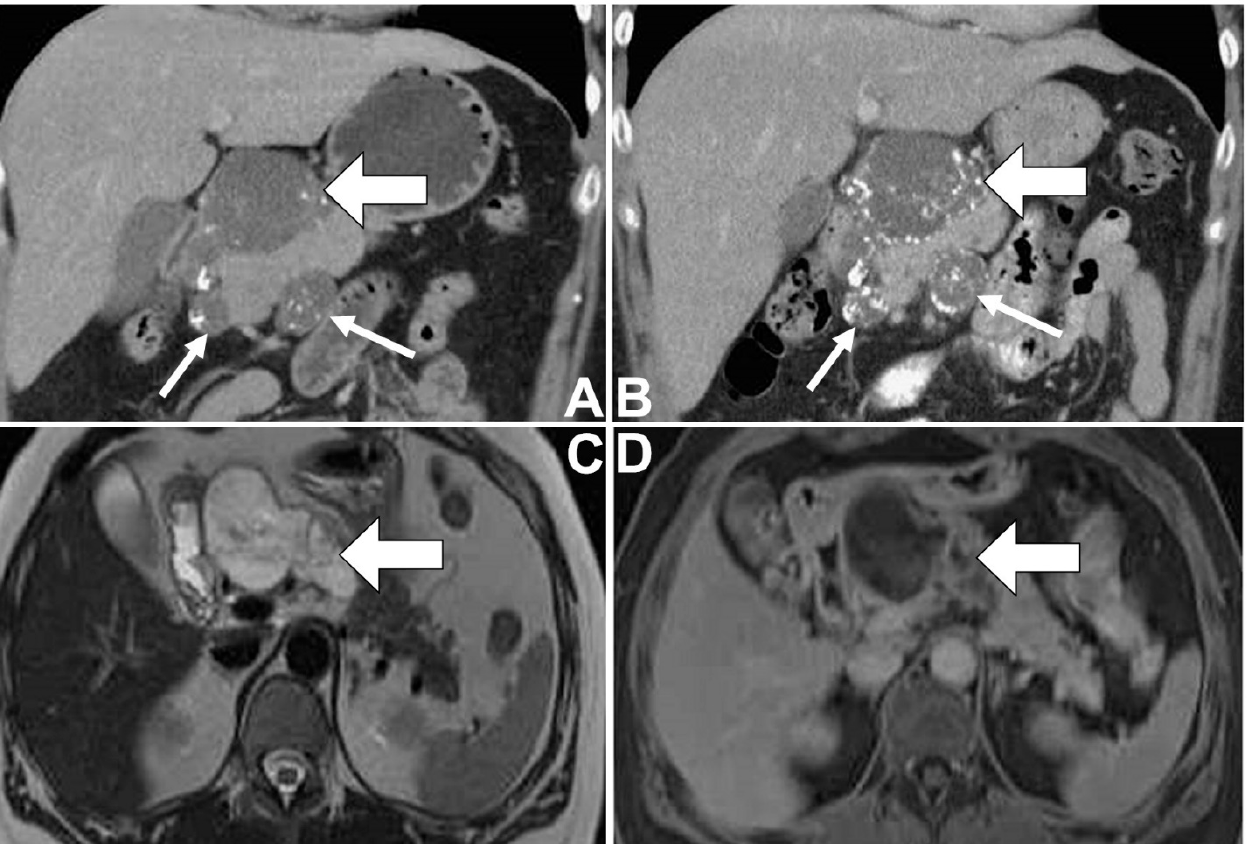
Figure 1. Colloid carcinoma of the pancreas in a 46-year-old woman. The coronal contrast-enhanced CT images at the time of initial presentation ( A ) and 10 months later ( B ) show a large well-defined lobulated cystic-appearing mass in the pancreatic head (thick arrow). Scattered peripheral and internal calcifications of the mass are noted. Lymphadenopathies (thin arrows) with similar imaging patterns of the mass are found around the pancreatic head. The follow-up image shows a slight increase in lesion size and calcifications. Marginal and septal enhancement and some intracystic enhancing foci are also found. The MRI at the time of initial presentation reveals a lobulated circumscribed hyperintense mass with some hypointense septa and foci on axial T2WI ( C ), as well as compatible CT enhancing patterns on axial T1WI gadolinium-enhanced delayed phase of MRI ( D